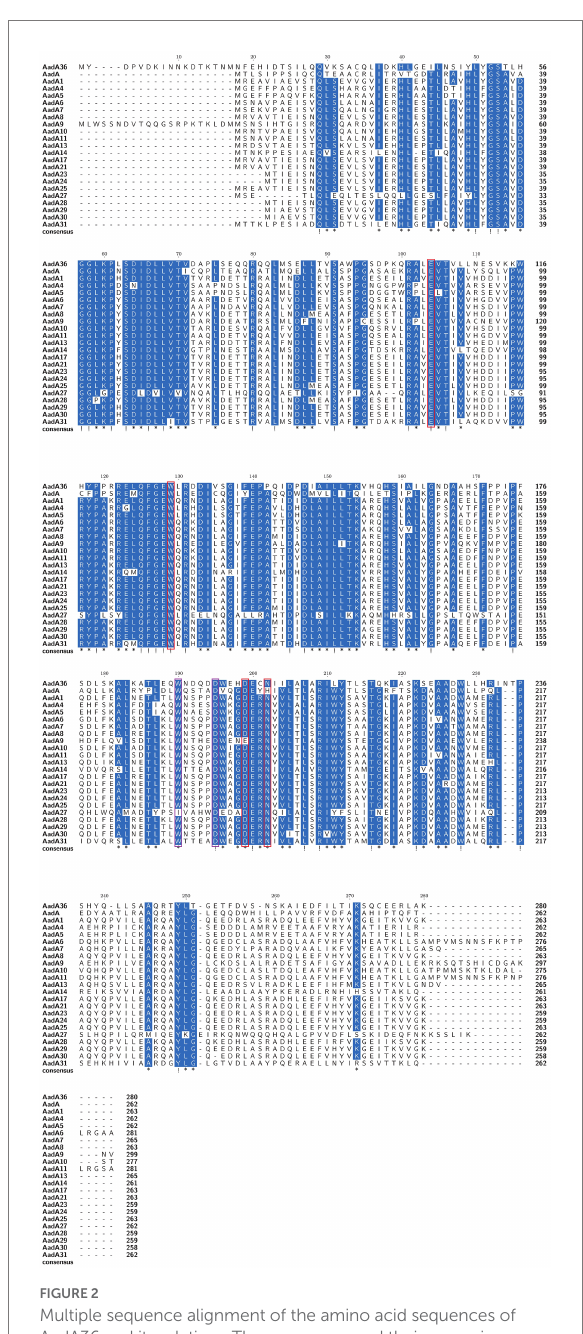
FIGURE 2 Multiple sequence alignment of the amino acid sequences of AadA36 and its relatives. The sequences and their accession numbers are as follows: AadA1 (AAO49597.1), AadA4 (AAN34365.1), AadA5 (AAF17880.1), AadA6 (CAJ32504.1), AadA7 (BAD00739.1), AadA8 (AAN41439.1), AadA9 (ABG49324.1), AadA10 (AAL36430.1), AadA11 (AAV32840.1), AadA13 (ABW91178.1), AadA14 (CAI57696.1), AadA17 (ACK43806.1), AadA21 (AAN87151.1), AadA23 (CAH10847.1), AadA24 (ABG72894.1), AadA25 (AET15272.1), AadA27 (CTQ57092.1), AadA28 (ANN23979.1), AadA29 (ANN23976.1), AadA30 (ANN23985.1), AadA31 (AUX81654.1) and AadA (Q8ZPX9.1). Exclamation marks indicate fully conserved residues, and asterisks indicate strongly similar residues. The red and purple frames indicate functional residues for spectinomycin and streptomycin, respectively. The numbers on the right represent the corresponding sequence